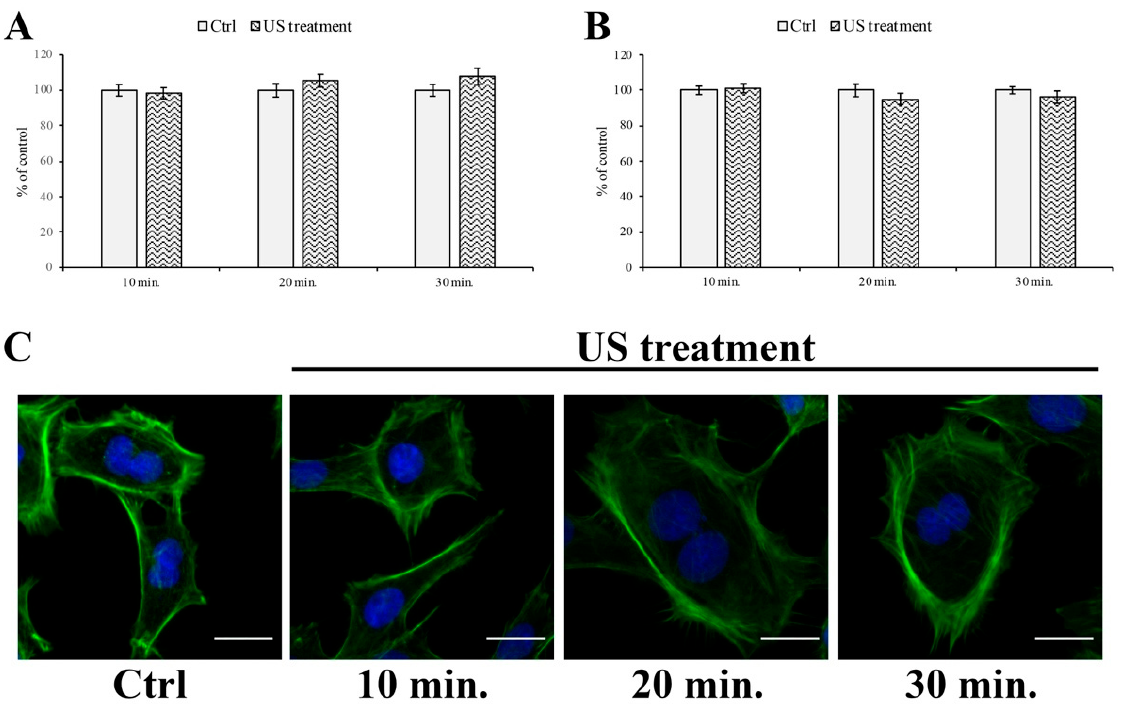
Figure 6. F-actin microfilament distribution and localization during US treatment on RBE4 cells. The microfilament distribution was not significantly altered during US treatment, even if a slight increase in peripheral F-actin surface appeared between 20 and 30 min of stimulus (panel A ), along with a small opposite decrease in the background actin filament (panel B ). Values are reported as percentages of the control (untreated cells), arbitrarily taken as 100%. The results are expressed as the mean ± S.E.M. of three independent experiments, performed in triplicate. Representative immunocytofluorescent images at different times of US stimulation were reported (panel C ). Five microscopic fields per treatment have been recorded. Total magnification 400×; scale bar: 25 µm.